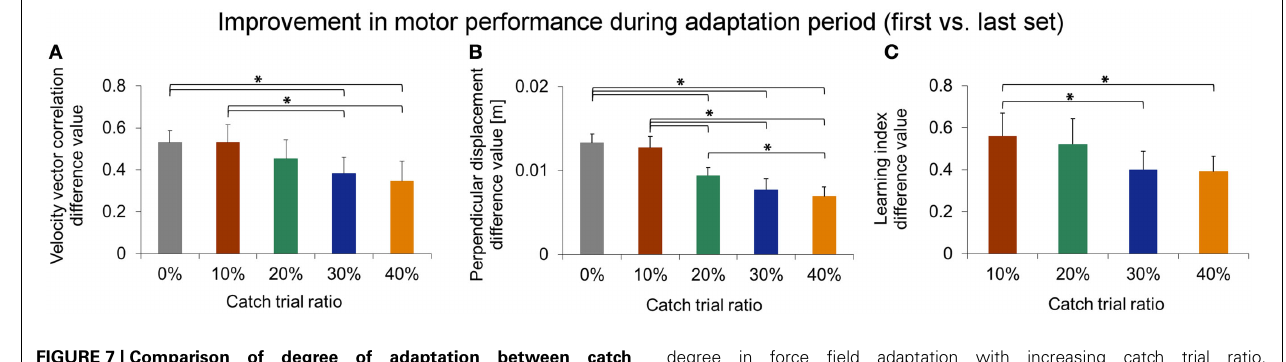
degree in force field adaptation with increasing catch trial ratio. All data is presented as mean values ± 95% confidence intervals; ( ∗ ) indicates significant differences between catch trial ratio groups.